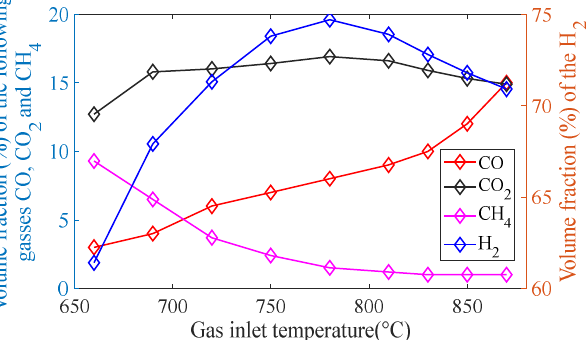
Figure 2. Performance of the reformer at different temperatures when the ratio of water to carbon is 2.8.